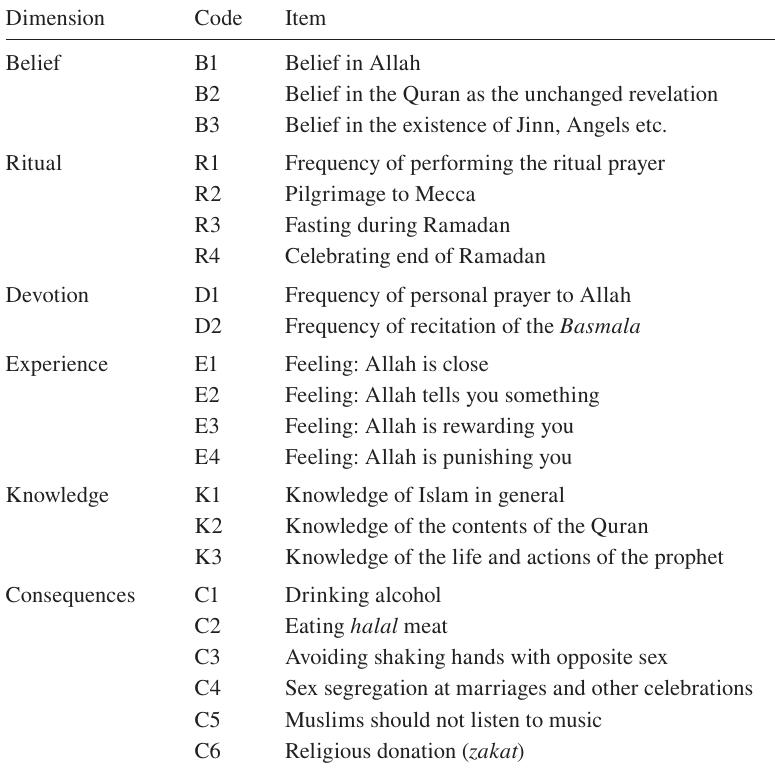
Table 3 : Indicators used for the single dimensions of religiosity